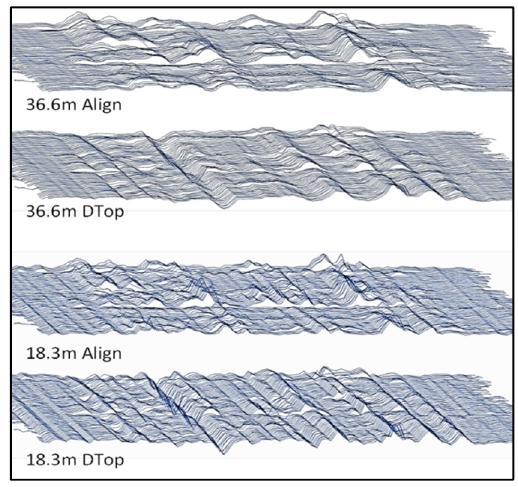
Figure 6. Visualised track geometry data comparing 36.6 m and 18.3 m SD base lengths .